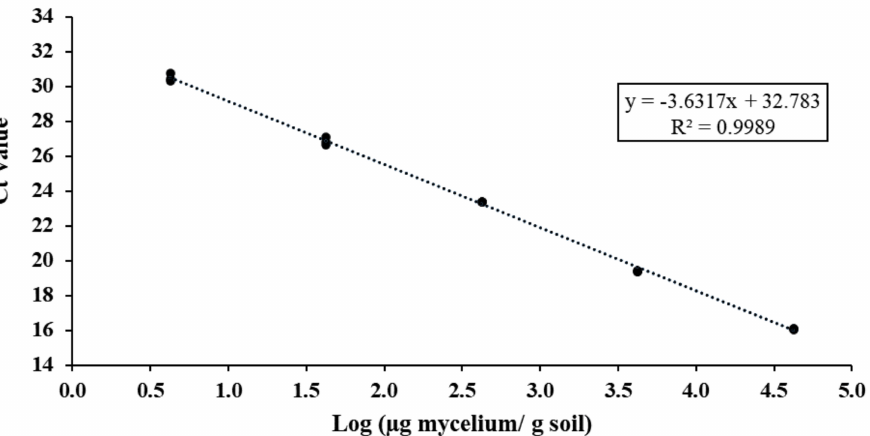
Figure 2. Real-time qPCR standard curve for T. claveryi DNA quantification in soil. The curve was generated by plotting the Ct values obtained from 10-fold serial dilutions of DNA standard sample against the logarithm of the quantity of mycelium in soil ( µ g/g). Efficiency for the primer set TerclaF3/R1 was